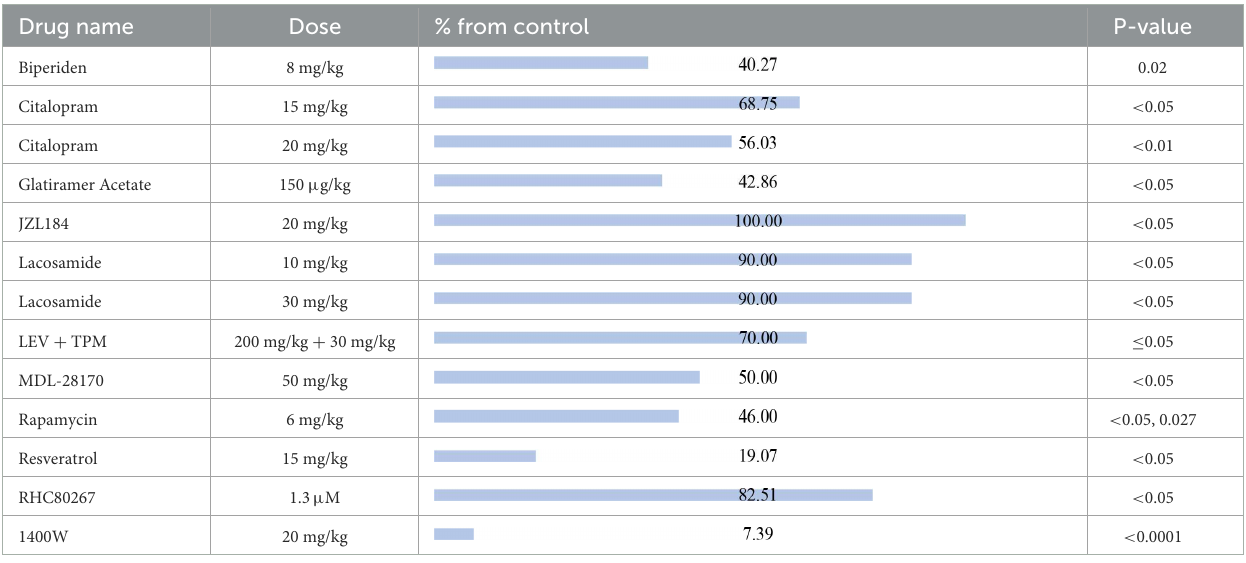
TABLE 4 Spontaneous recurrent